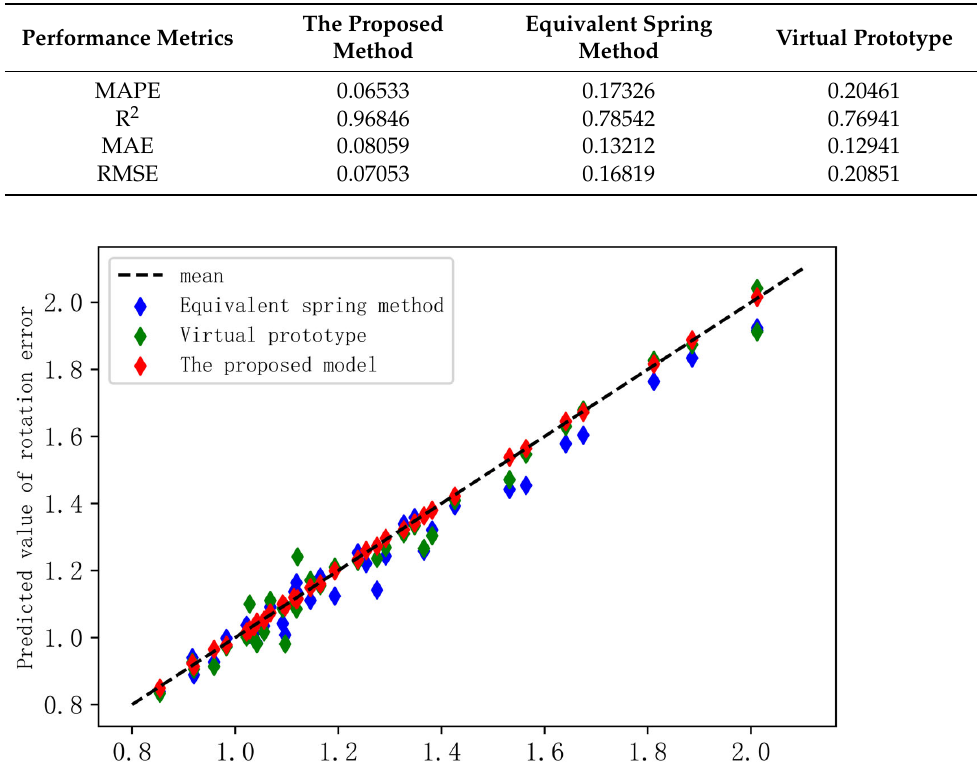
Table 6. Comparison of regression accuracy of three models.